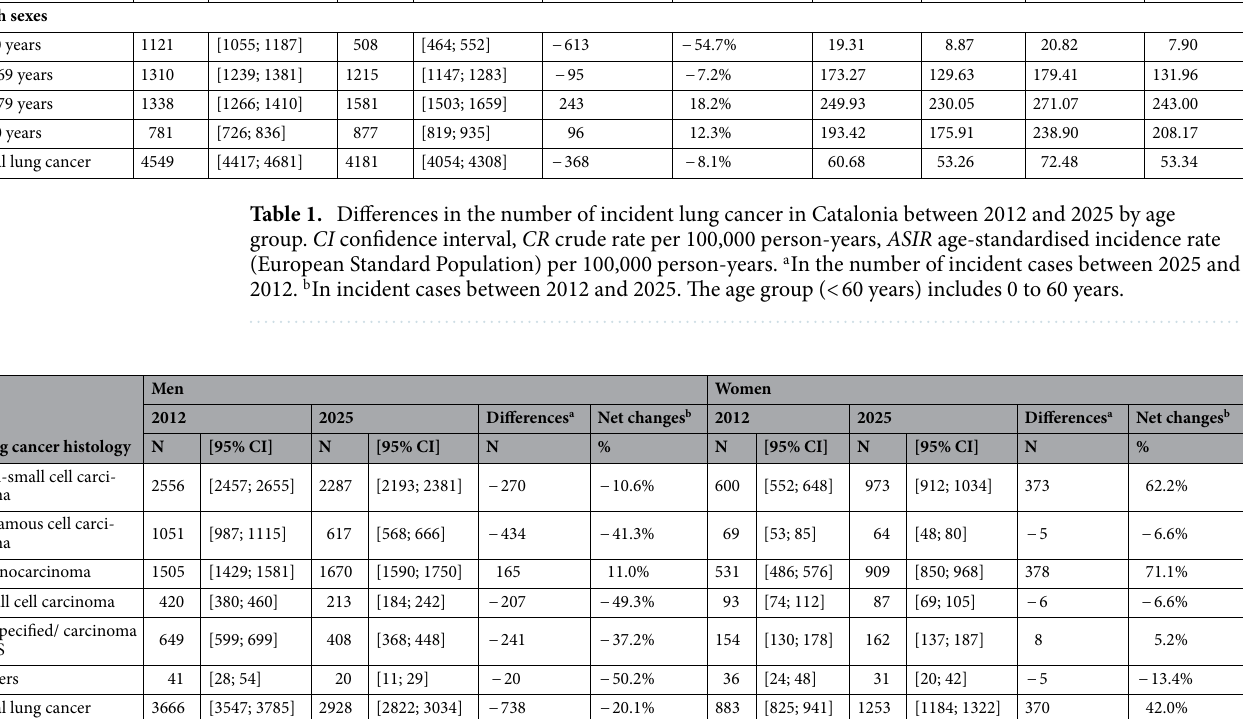
Lung cancer trends show a strong divergence by sex and age group as well as marked differences in histology. In men under the age of 70, incidence is clearly decreasing in absolute terms, and projections show that this trend